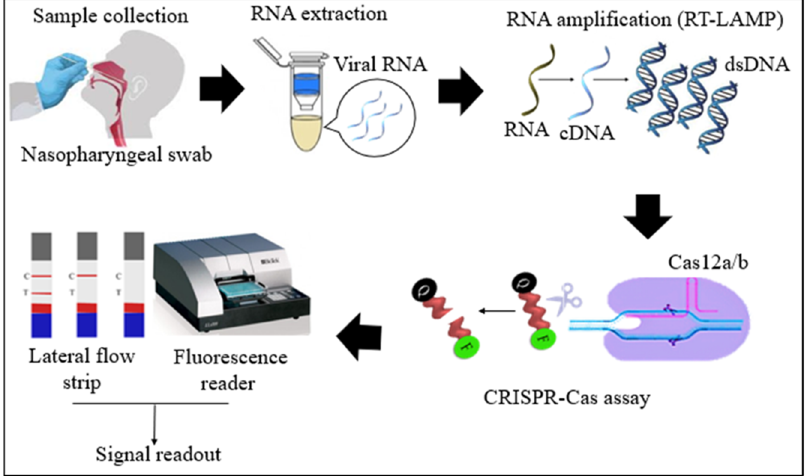
Figure 3. Schematic diagram of RT-LAMP CRISPR-Cas12a/b-based detection of SARS-CoV-2. Sam- ples (nasopharyngeal swabs) were collected from symptomatic and asymptomatic individuals, and viral RNAs were extracted. With the RT-LAMP step, viral RNAs are first converted into cDNAs, which are subsequently amplified. The amplicons were targeted in CRISPR-Cas-based detection, and the results of the tests were visualized via colorimetry or a fluorescence assay.